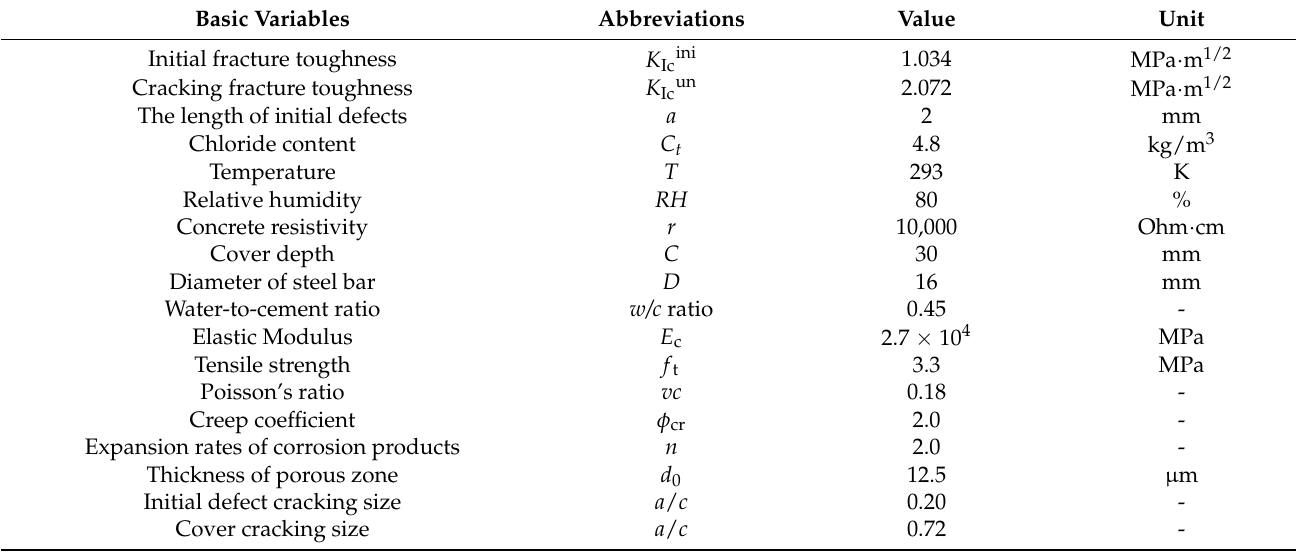
Table 6. The value of basic parameters to